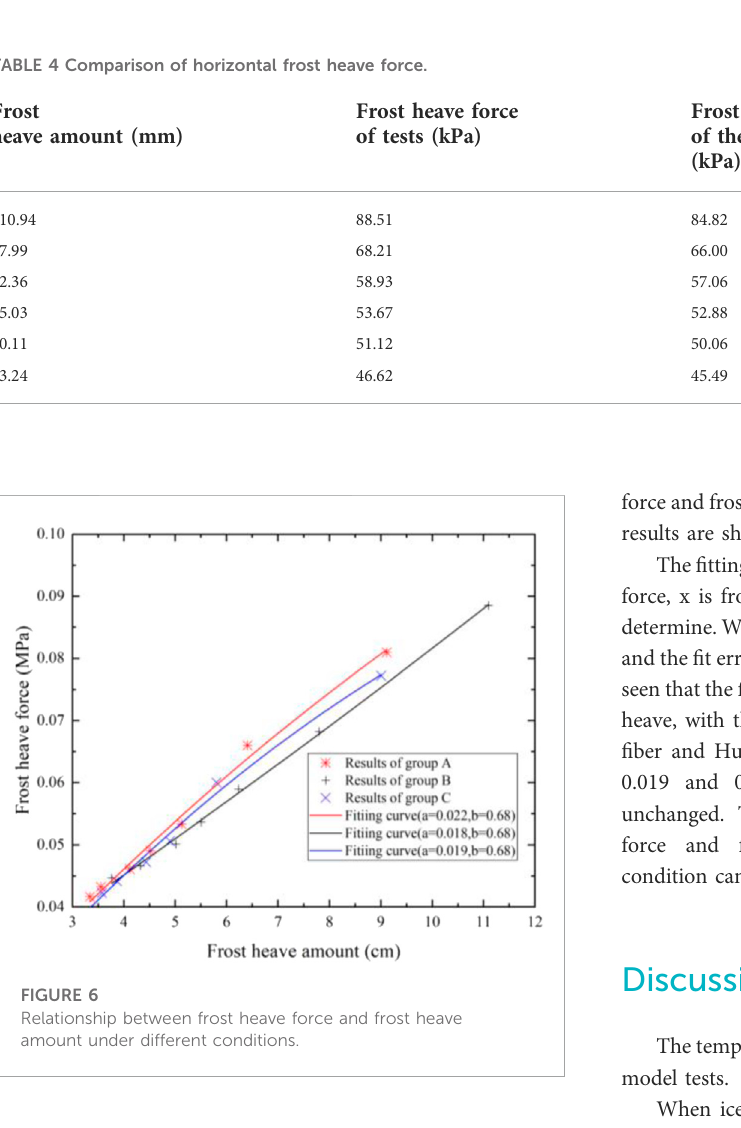
fi t the relationship between the horizontal frost heave force and amount (Zhou, 1993). Therefore, the power function is selected for the fi tting curve. MATLAB was used to fi t the frost heave